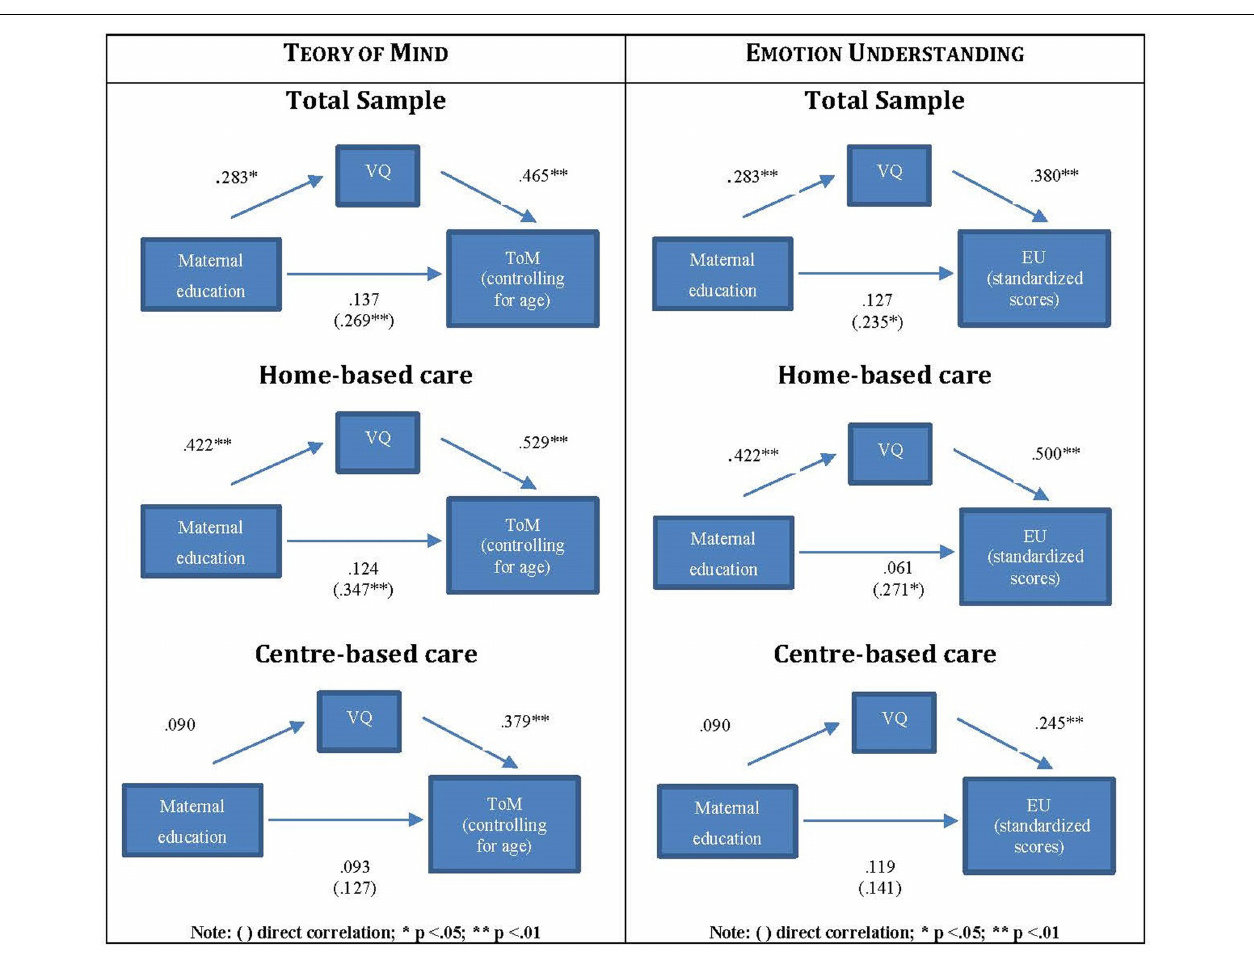
FIGURE 1 | The mediation of language between maternal education and